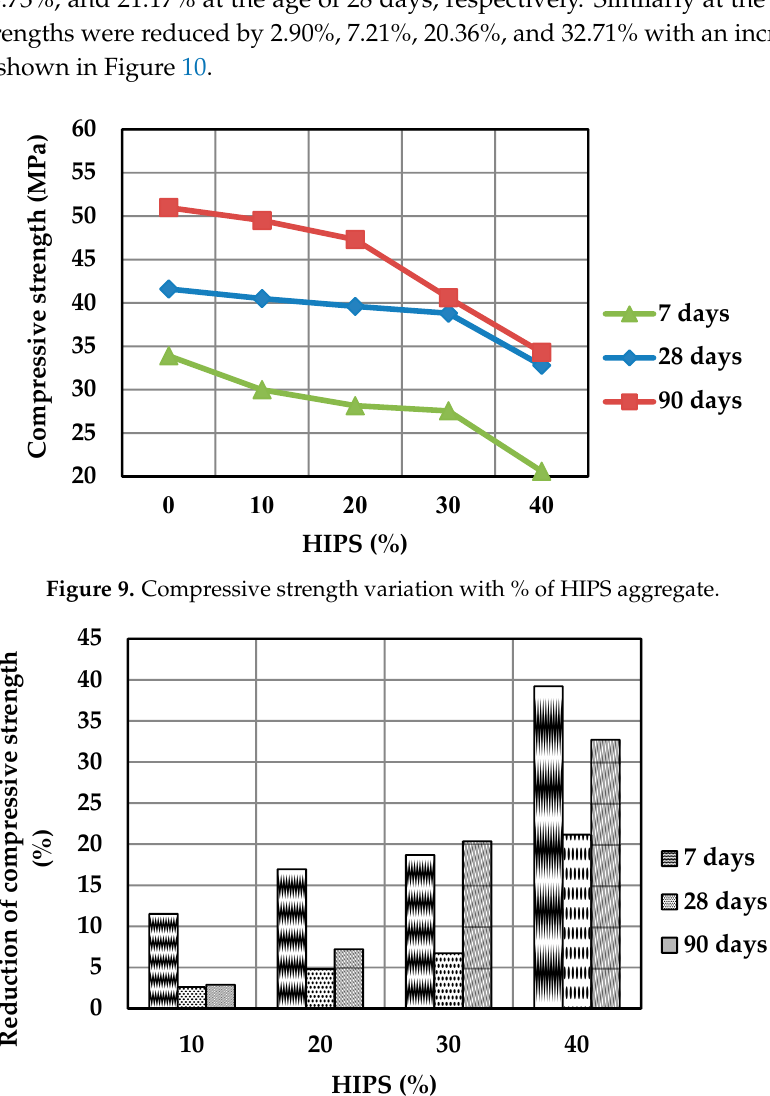
Figure 10. Graph represents % of reduction in compressive strength with varying % of HIPS. 290